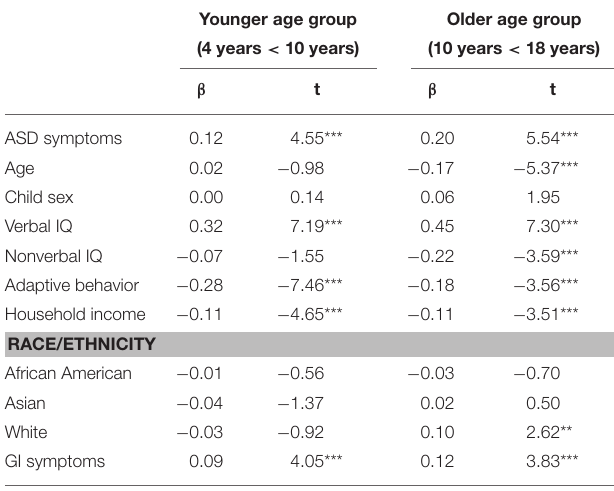
TABLE 4 | Unique contributions of child and family factors to externalizing symptoms.